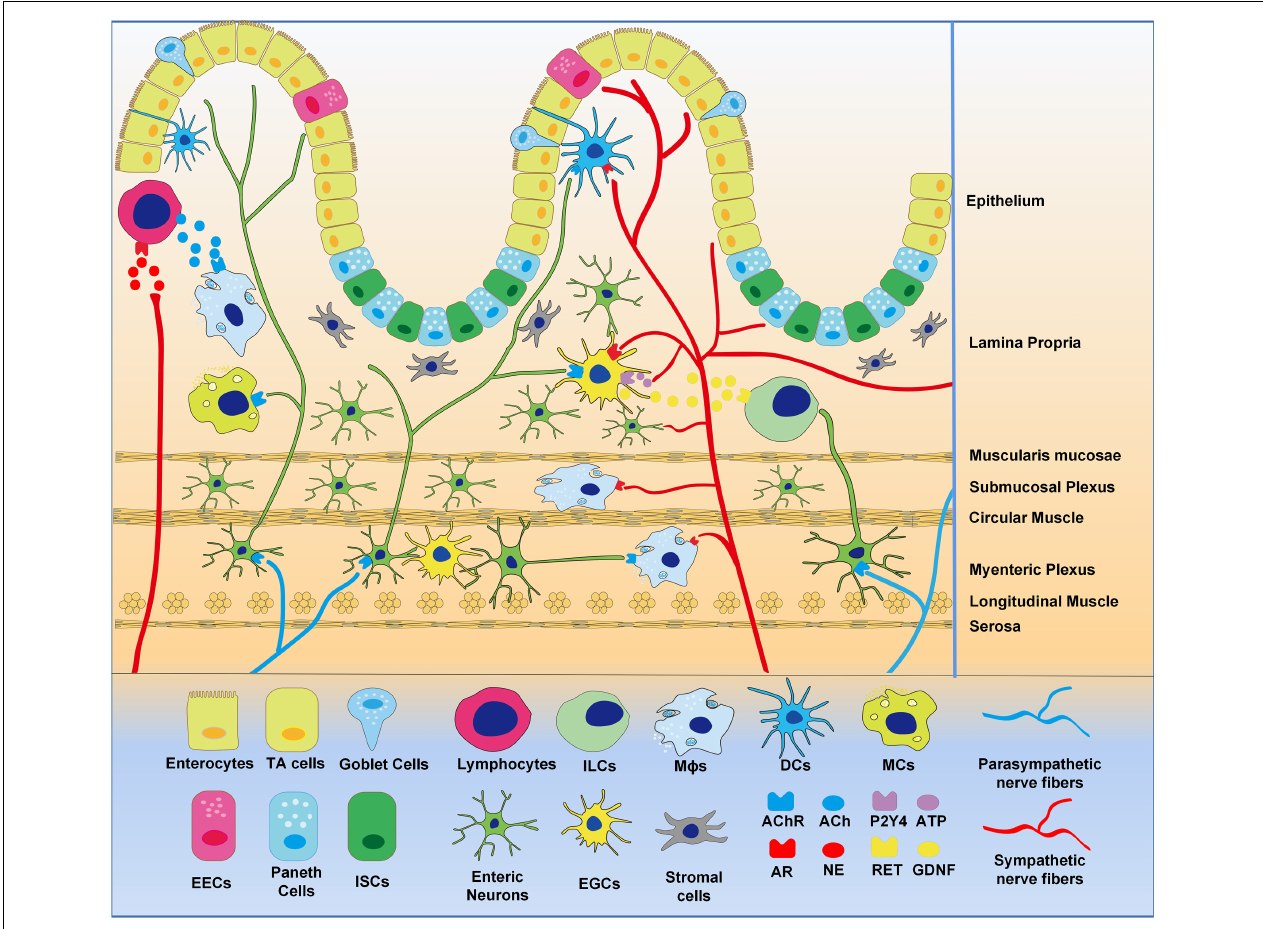
FIGURE 1 | Distribution of intestinal neural network. Extrinsic sympathetic and parasympathetic nerve fibers enter the whole layer of the intestinal wall to form complex neural networks with intrinsic enteric nervous and EGCs that innervate gastrointestinal epithelial and immune cells. Epitheliums are differentiated from intestinal stem cells, demonstrating enterocytes, endocrine cells, goblet cells, and Paneth cells. Intestinal stromal cells and various immune cells reside in the intestinal wall, the later including macrophages (M φ s), lymphocytes, mast cells (MCs), dendritic cells (DCs), and innate lymphoid cells (ILCs). Intestinal neural networks regulate intestinal cells, via neurotransmitters (ACh, NE, ATP etc.), neurotrophic factors (GDNF etc.) and receptors (AChR, AR, P2Y4, RET